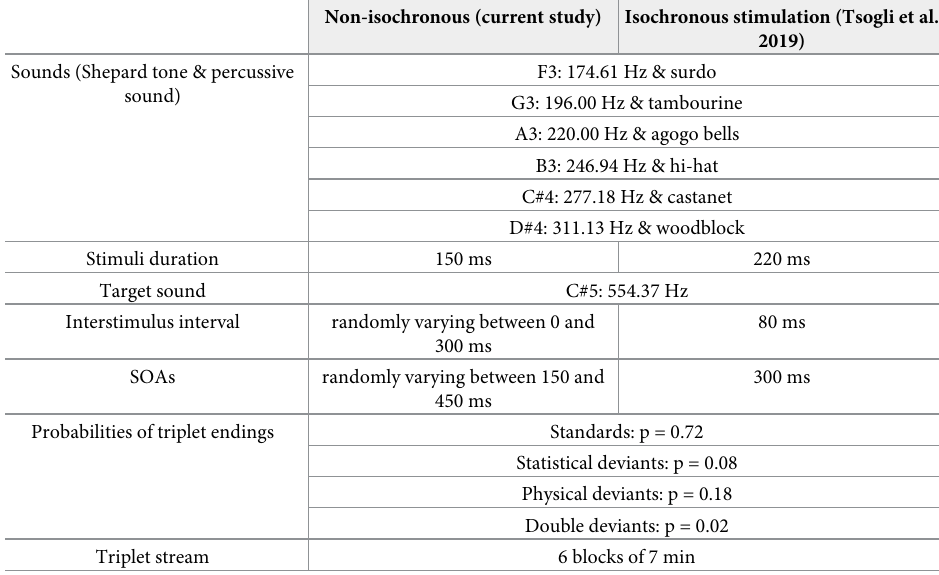
Table 2. Comparative view of experiment design details for the two experiments. Interstimulus interval denotes the silent interval between the offset of one tone and the onset of the next one. SOAs denote the interval between the onset of one tone and the onset of the next